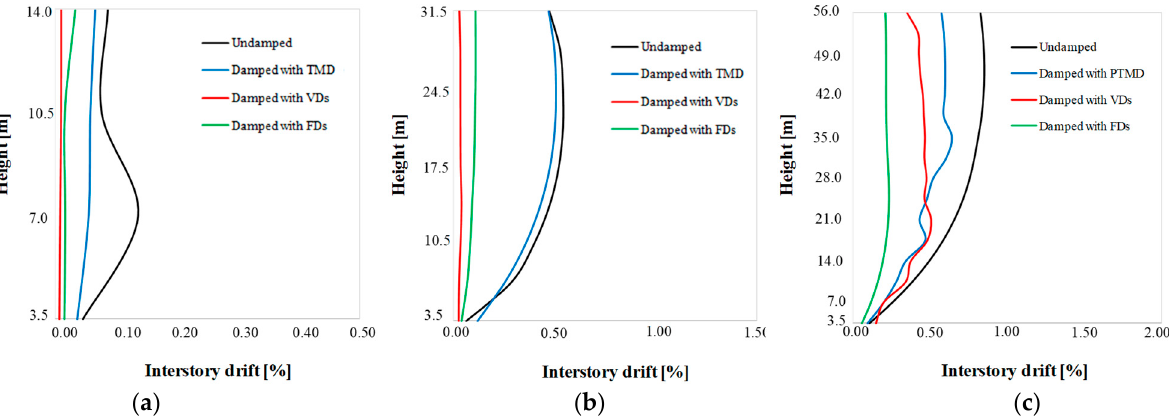
Figure 14. Maximum interstory drift for ( a ) low-rise, ( b ) mid-rise, and ( c ) high-rise building in the longitudinal direction.